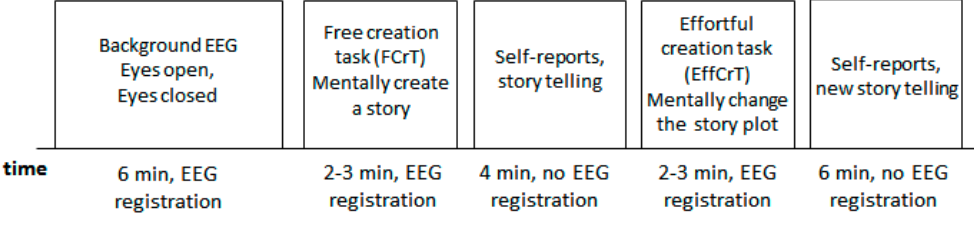
Figure 1. The timeline of the EEG recording.